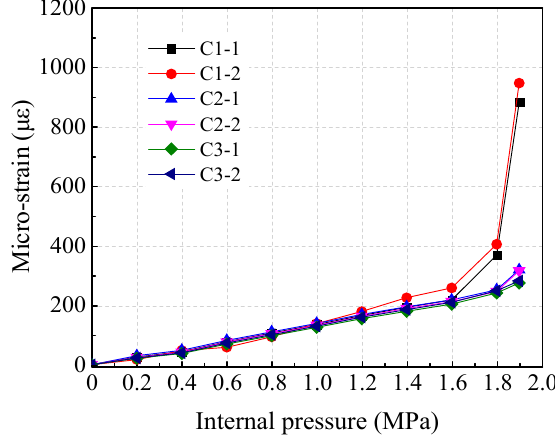
Figure 9. Changes of outside concrete strain with internal water pressure.